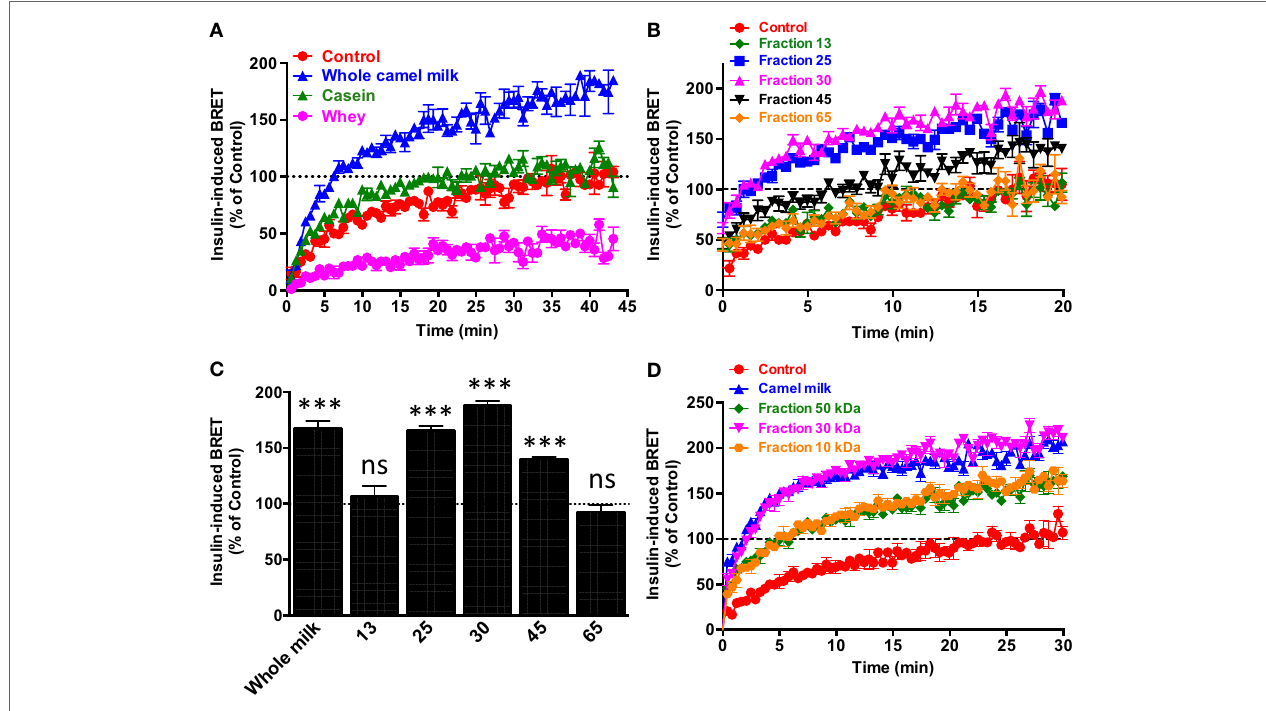
FigUre 5 | effect of camel milk fractions on BreT signals. HEK293 cells transiently co-expressing hIR–Rluc8 and Grb2–Venus were first pre-treated or not (control, red circle) 30 min with either whole camel milk (blue triangle) or its different fractions obtained by either centrifugation (a) , gel filtration chromatography (B,c) , or molecular weight cutoff using appropriate filters (D) . Real-time BRET measurements were then performed in the absence or presence of stimulation with 100 nM of insulin as indicated. (c) The comparison of the maximal values of insulin-induced BRET averaged from the plateau of the curves shown in (B) . Data are representative of three independent experiments (a,D) or mean ± SEM of three experiments (B,c) all performed in triplicate